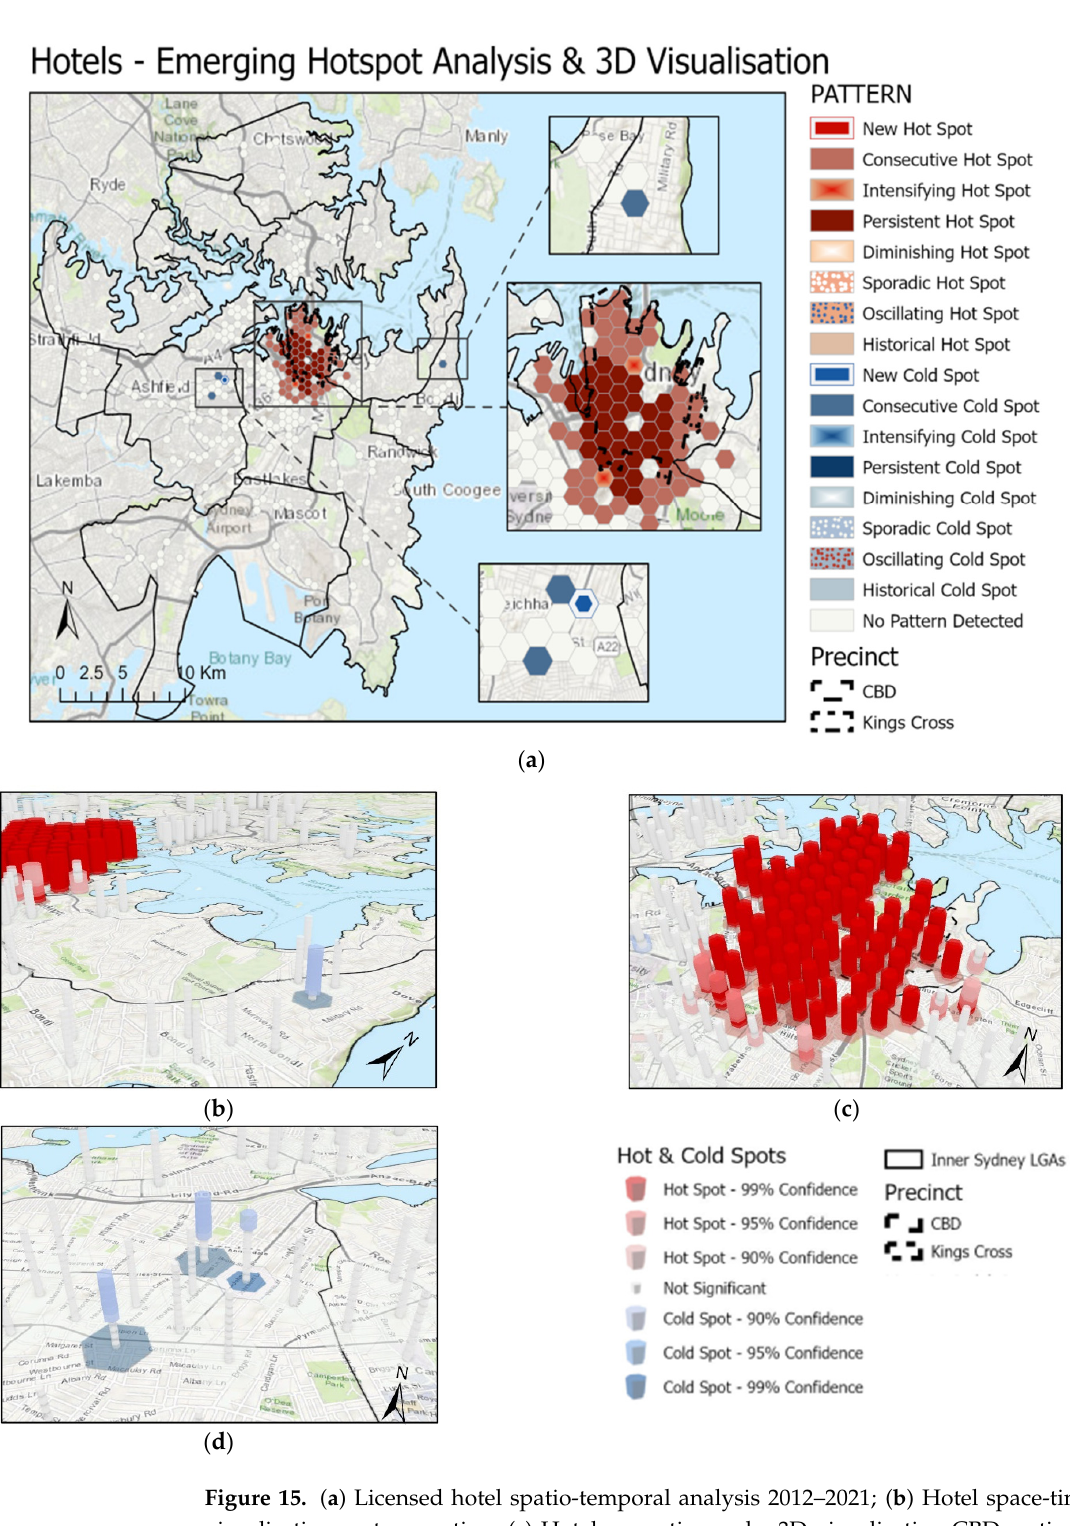
Figure 15. ( a ) Licensed hotel spatio ‐ temporal analysis 2012–2021; ( b ) Hotel space ‐ time cube 3D visualisation eastern section; ( c ) Hotel space ‐ time cube 3D visualisation CBD section; ( d ) Hotel space ‐ time cube 3D visualisation western section.